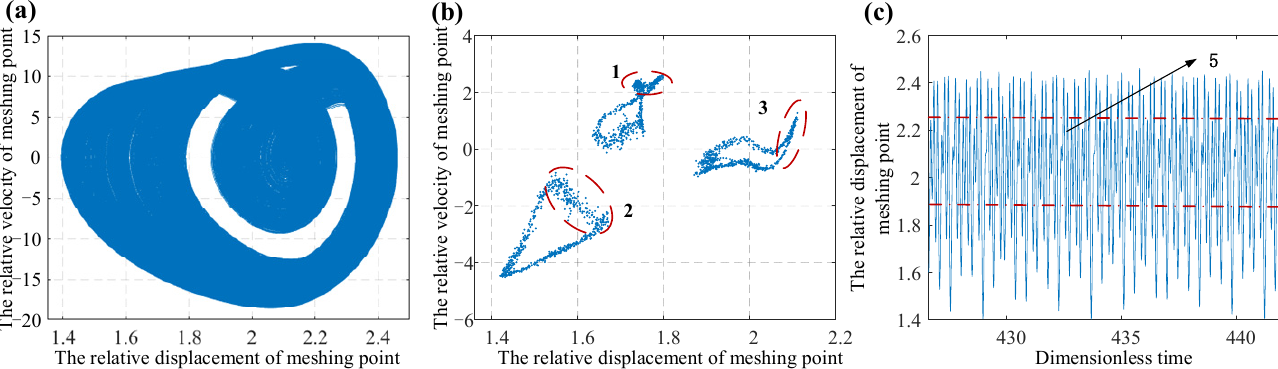
Figure 11. System response diagram with D = 1.5. ( a ) Phase diagram. ( b ) Poincare section diagram. ( c ) Time domain